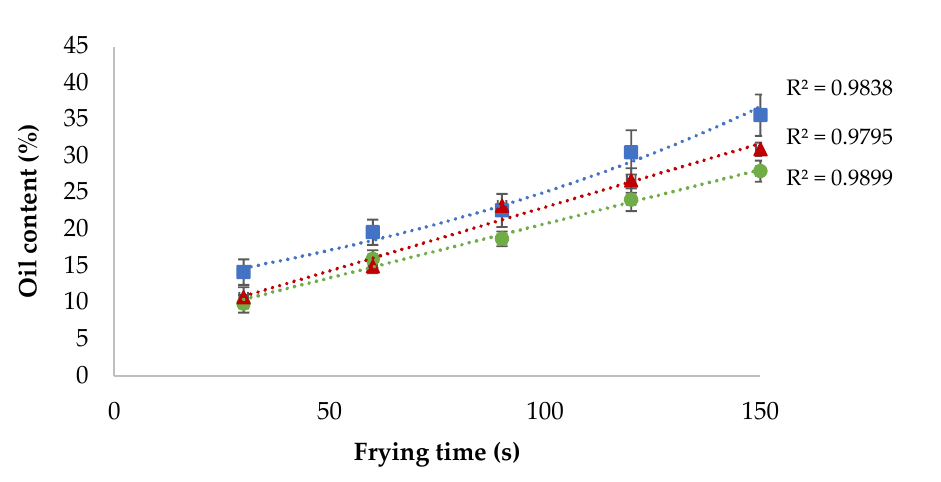
Figure 3. Mushroom slices oil capture kinetics during frying at 170 °C. Mushroom, noncoated; mushroom with methyl cellulose coating; mushroom with kappa-carrageenan coating.